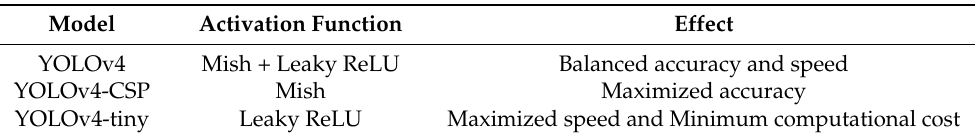
Table 4. Summary of activation function used and the reason why the specified activation functions were used.